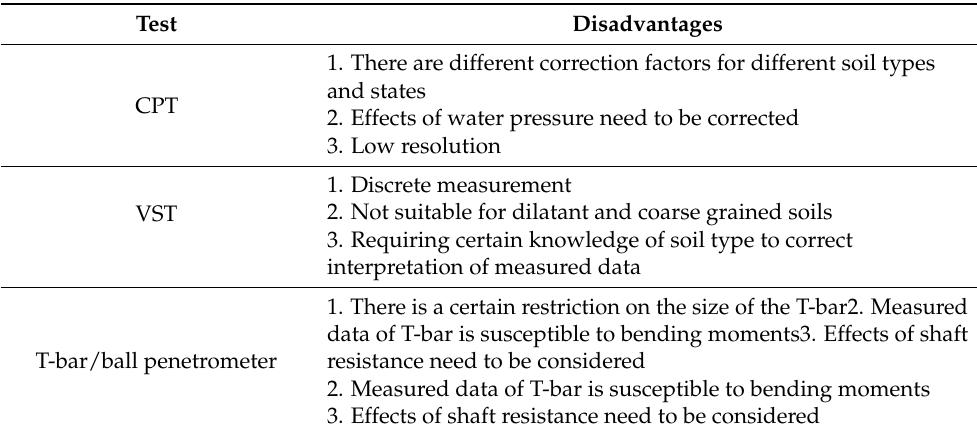
Table 1. Disadvantages of CPT, VST, and T-bar/ball